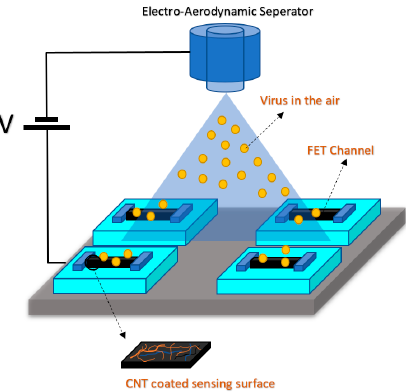
Figure 17. The carbon nanotubes (CNT) sensor working based on a back-gate biasing and the sample is introduced by an electro-aerodynamic separator without using wet samples.